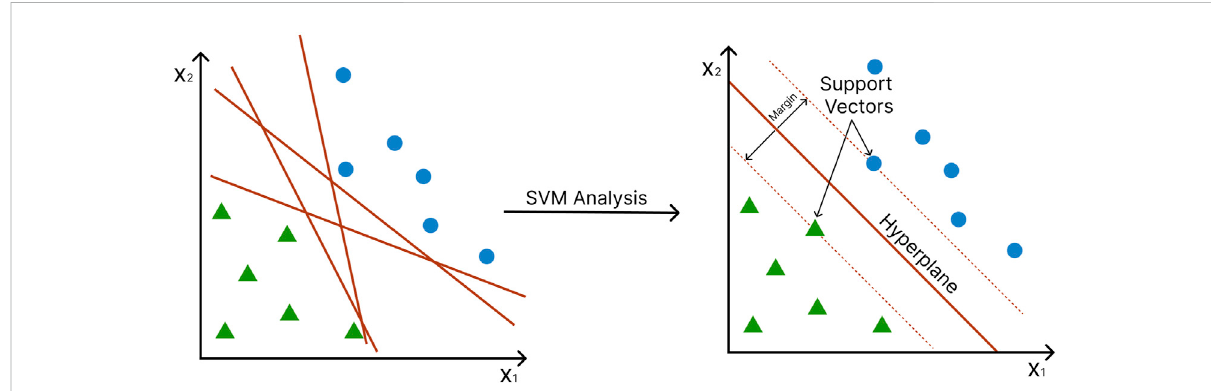
FIGURE 5 Support VectorMachines(SVM)construct ahyperplaneto separate data into twoclasses. Axes representdifferentfeatures.Green trianglesand blue circles represent different conditions (e.g., disease vs. control). The margin (red dotted line) is the distance between the hyperplane and the support vectors (the nearest data point of each class).